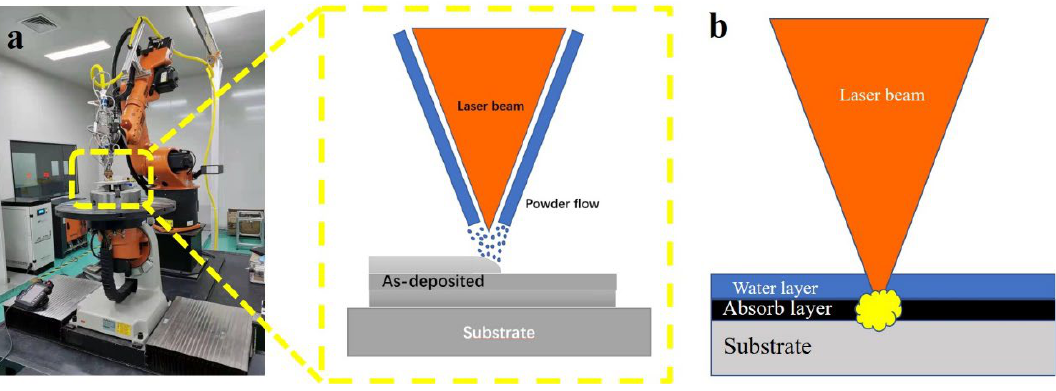
Figure 1. The schematic image of LMD ( a ) and LSP ( b ). Table 2. The detailed laser melting deposition and laser shock peening parameters.